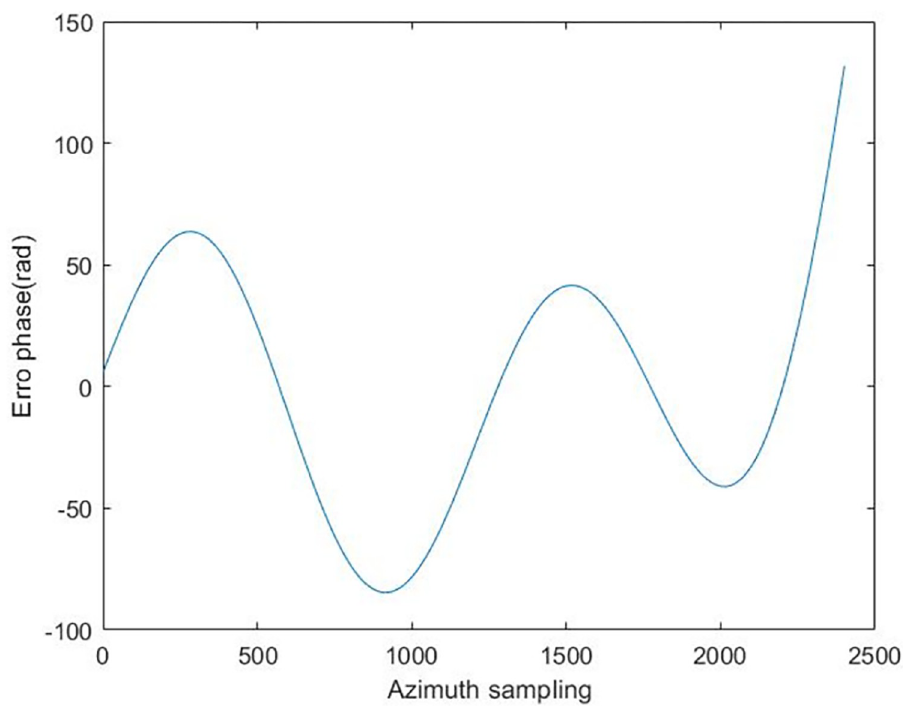
Fig 4. Error phase added to simulation